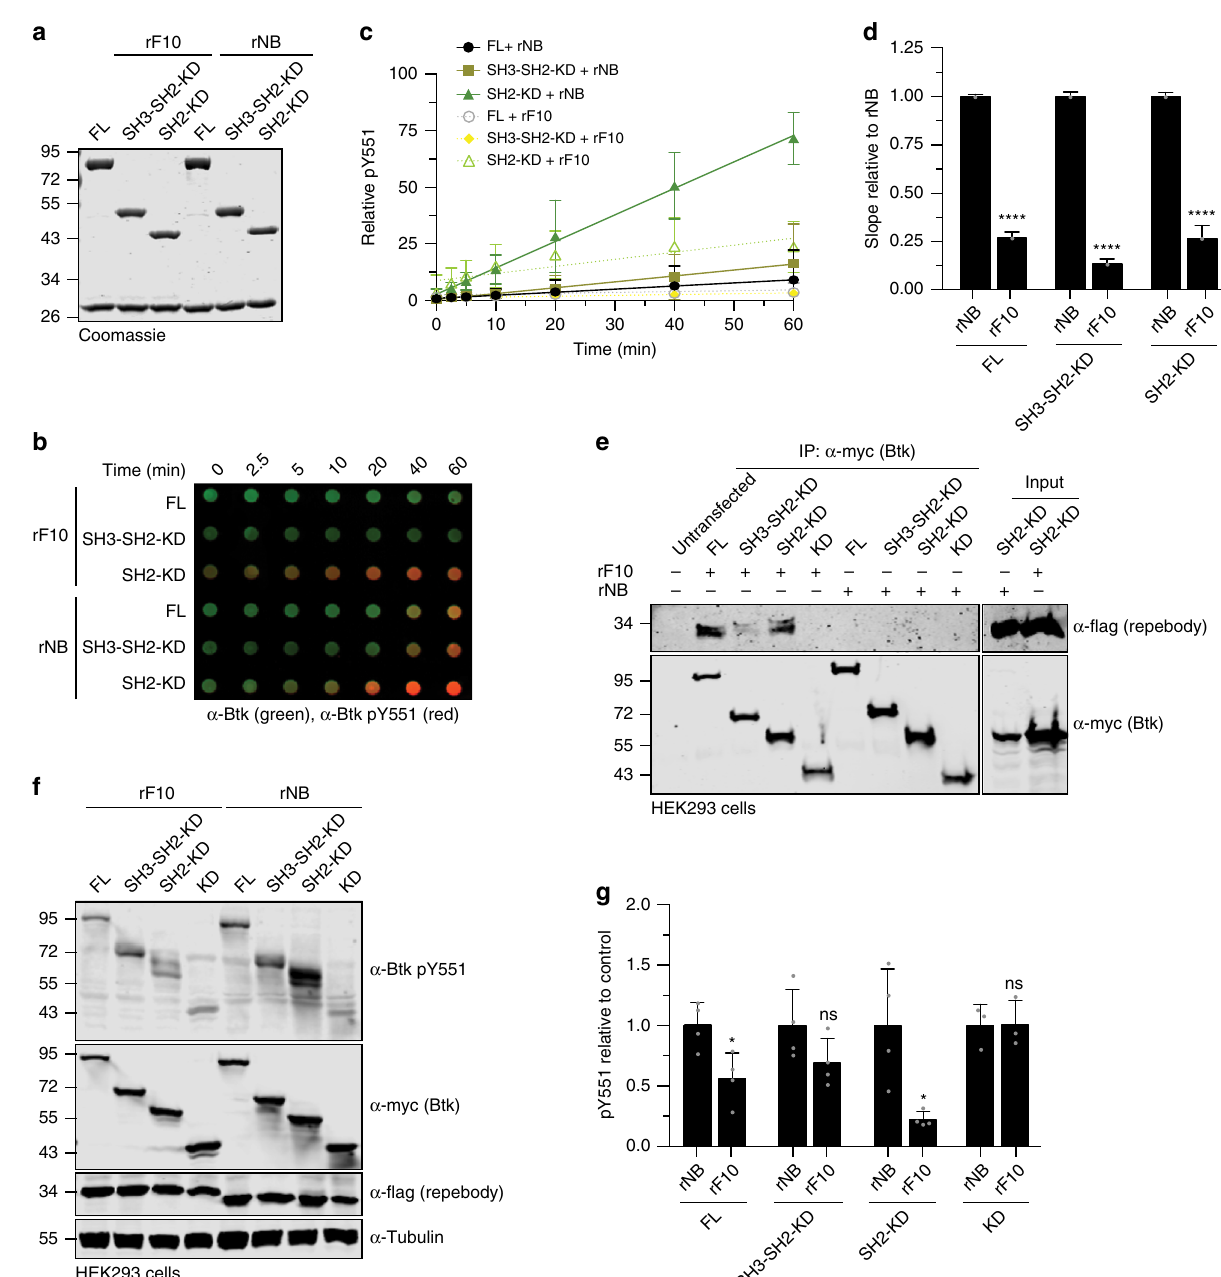
Fig. 6 rF10 repebody inhibits Btk activation in vitro and in cells. a Representative SDS-PAGE analysis of in vitro autophosphorylation assay containing recombinant Btk proteins mixed with rF10 or non-binding (rNB) control repebodies. b In vitro autophosphorylation assay performed with recombinant Btk protein with 2-fold excess of rF10 or rNB at room temperature. The levels of pY551 (red channel) and total Btk (green channel) were assessed using immunoblotting in a dot blot apparatus. c Btk autophosphorylation kinetics in the presence of rF10 (dashed lines) or rNB (continuous lines) repebodies shown in b normalized to total Btk signal and the calculated slopes of linear fi ts (relative velocities). Data are mean ± SD of three independent experiments ( n = 6). d Relative velocities of Btk autophosphorylation relative to control repebody. Data are mean ± SD of three independent experiments ( n = 3) and P -values relative to rNB were calculated using an unpaired t -test. e HEK293 cells were transiently co-transfected with indicated Btk constructs and